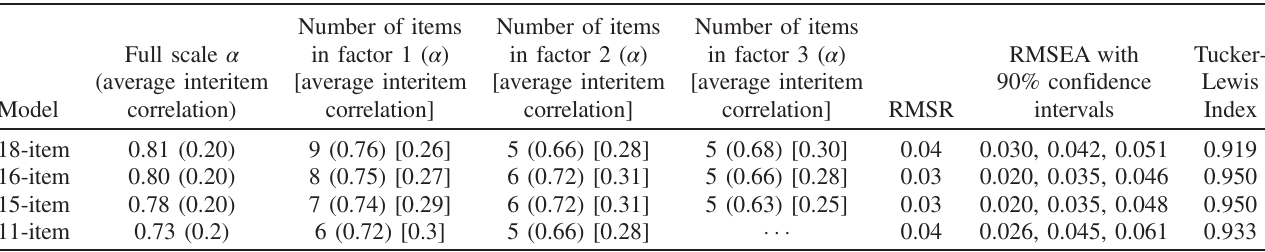
TABLE VIII. Internal reliability estimates and adequacy test indices for EFA factor structures.